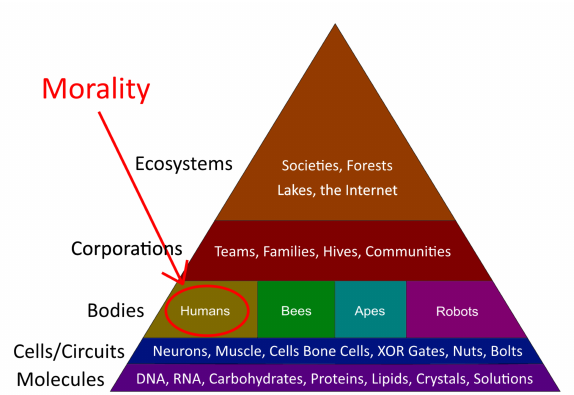
Figure 1: Modern anthropocentric